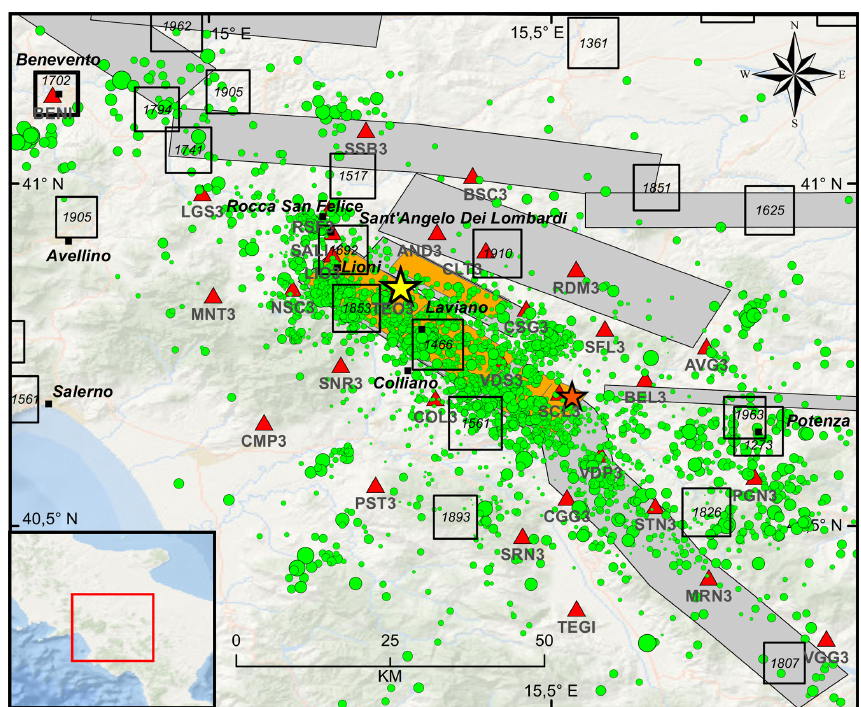
Figure 1. Epicentral map of the earthquakes (green circles) recorded by the Irpinia Seismic Network (ISNet, red triangles) from 2008 to 2020 (http://isnet-bulletin.fisica.unina.it/cgi-bin/isnet-events/isnet.cgi, last access: 1 June 2021). The yellow and orange stars refer to the epicentral location of the 1980, M 6.9 and of the 1996, M 4.9 earthquakes, respectively. Historical seismicity is shown with black squares ( I 0 ≥ 6–7MCS; Mercalli–Cancani–Sieberg). Seismogenic sources related to the Irpinia fault system are indicated by orange rectangles; potential sources for earthquakes larger than M 5.5 in surrounding areas are indicated in grey (Database of Individual Seismogenic Sources, DISS, Version